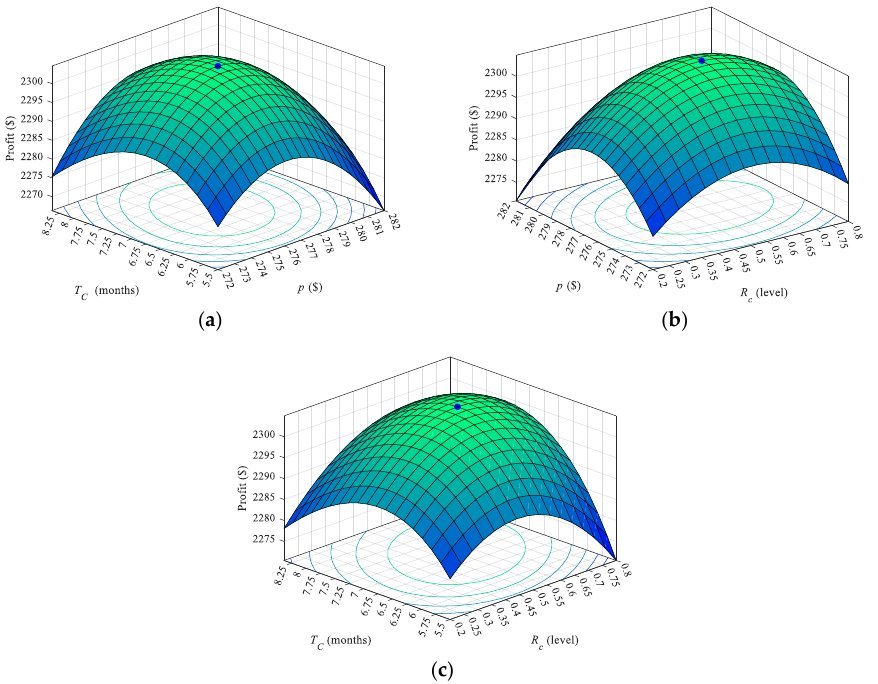
Figure 9. Profit function ( τ ) with regard to: ( a ) the selling price ( p ) and cycle time ( T C ); ( b ) the manufacturer’s carbon emission reduction level ( R c ) and selling price ( p ); ( c ) the manufacturer’s Fractal Fract. 2022 , 6 , 26 carbon emission reduction level ( R c ) and cycle time ( T C ).